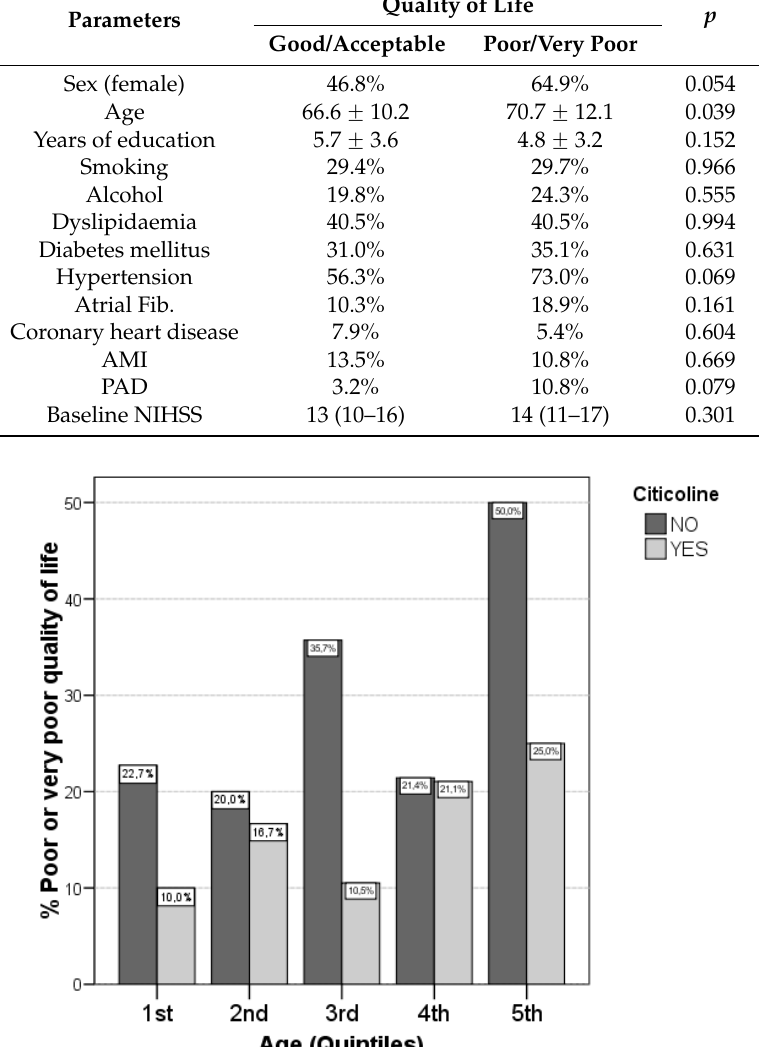
Figure 2. Citicoline compared with quality of life for different age groups. Patients not treated with citicoline were more likely to have a poor quality of life in all age subgroups. Quintiles: 1st: <60,